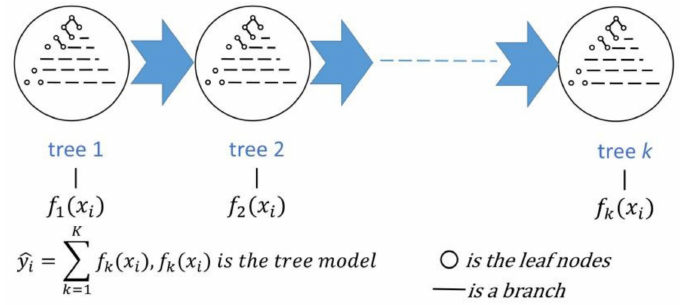
Figure 6. The XGBoost model used for